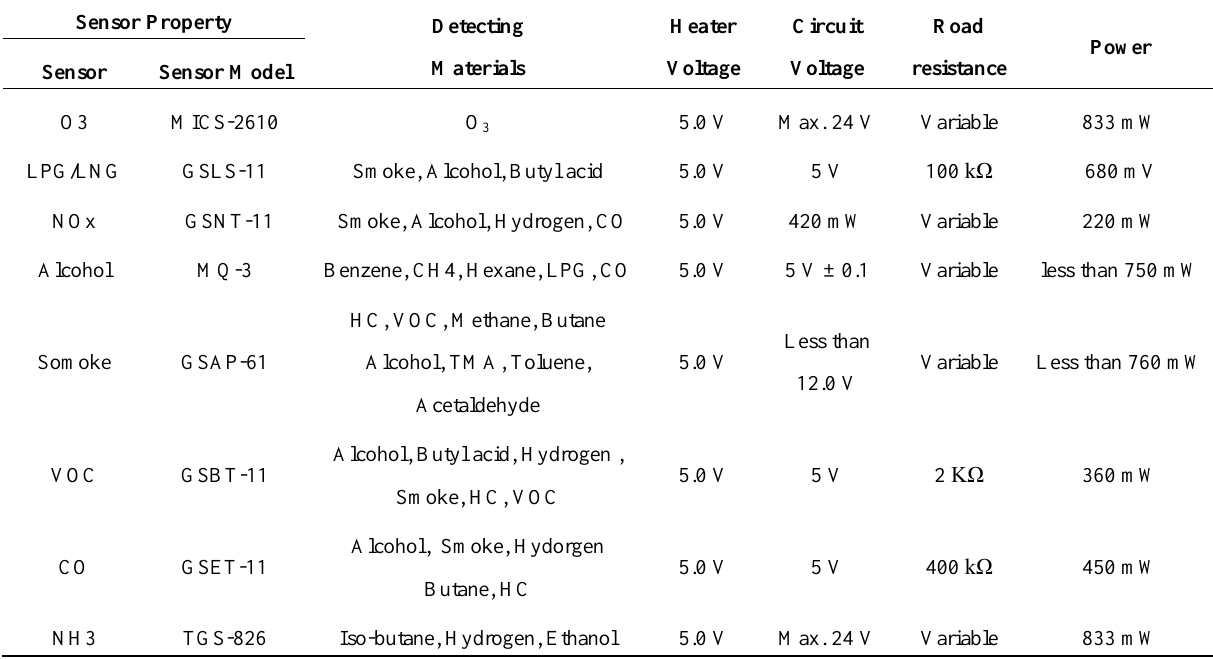
Table 1. Specifications of the gas sensors.